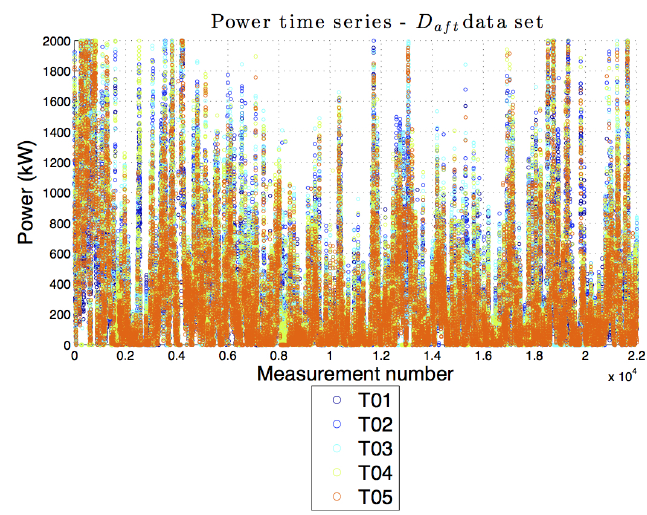
Figure 3. The power time series: D aft data